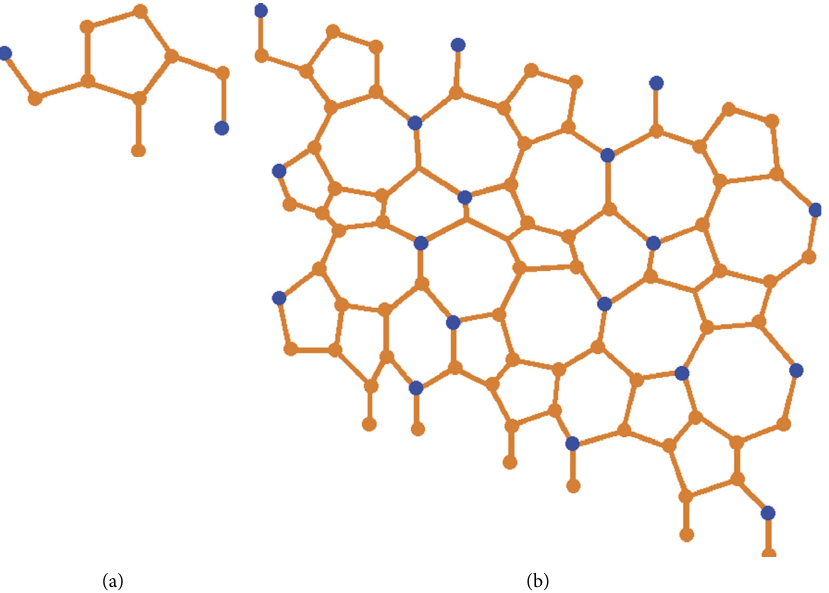
Figure 1: (a) contains unit cell of SiC